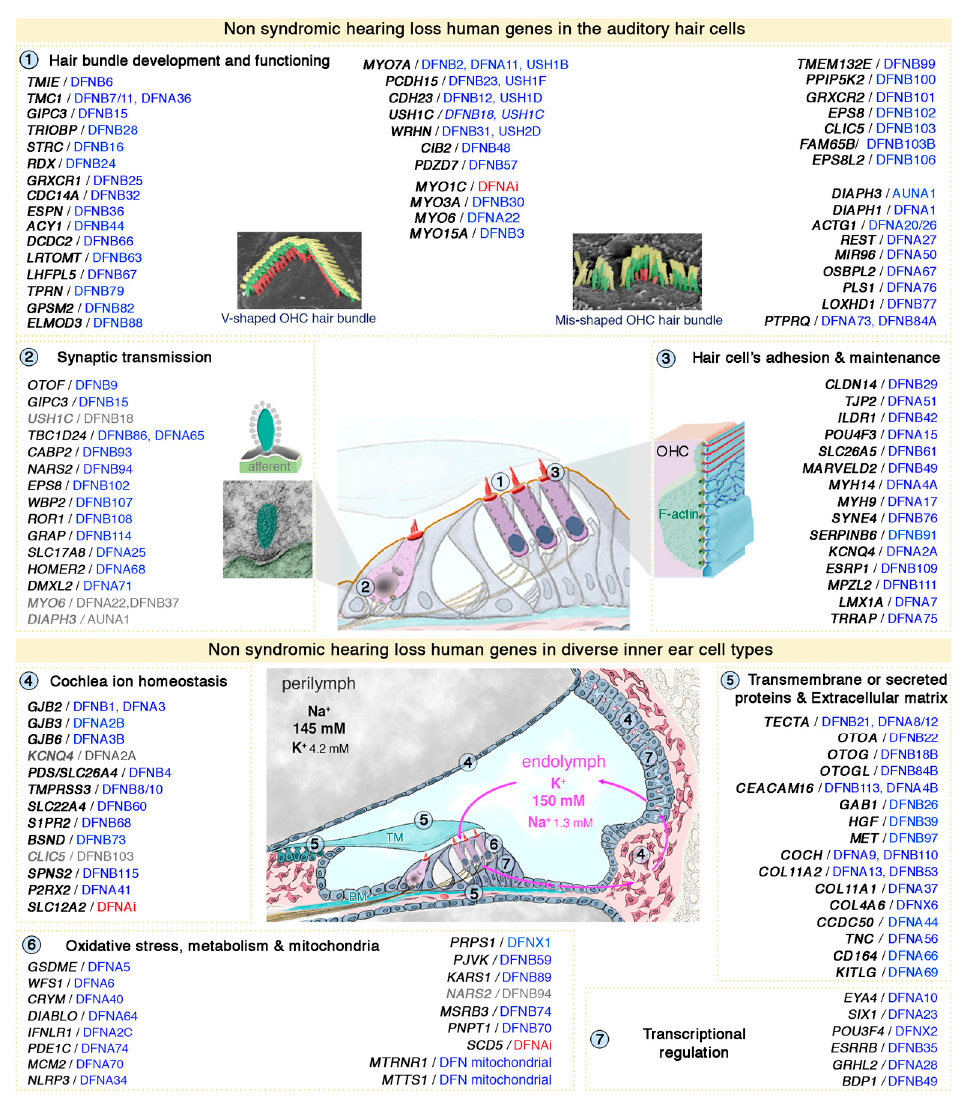
Figure 3. Functional stratification genes/proteins causing human isolated deafness hearing loss. Based on their established role and characterization of corresponding animal models, the human deafness genes ( DFNA DFNB DFNX AUNA ) can be grouped into several functional categories: (1) hair bundle development and functioning, (2) synaptic transmission, (3) hair cell’s adhesion and maintenance, (4) cochlea ion homeostasis, (5) transmembrane or secreted proteins and extracellular matrix, (6) oxidative stress, metabolism and mitochondrial defects, and (7) transcriptional regulation. DFNAi (red) denotes autosomal-dominant forms of deafness with undefined locus number. The genes/loci in grey denote that they share several functional categories. More detailed information regarding the deafness causative genes are provided in Table S1.